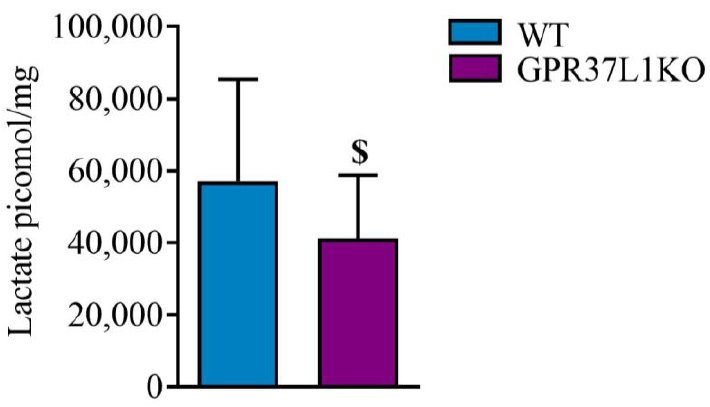
Figure 8. Effect of GPR37L1 deletion on the level of lactate in the dorsal hippocampus. n = 16/group. Statistical analysis was carried out using Student’s t -test. Results are expressed as Mean ± SD. $ p > 0.05 < 0.1.